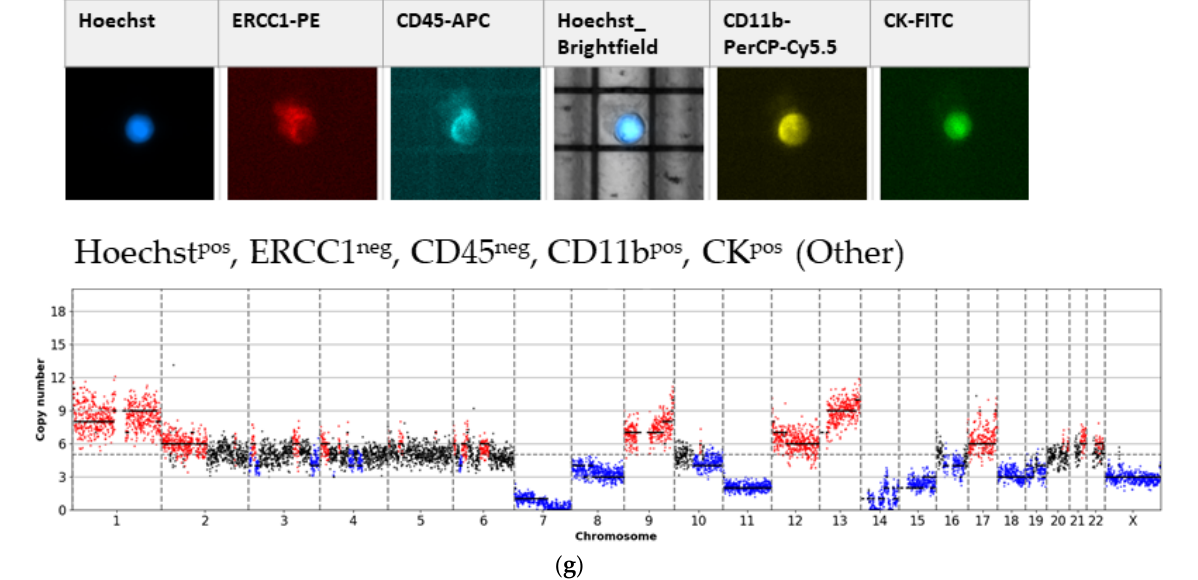
Figure A5. DEPArray TM fluorescence panel of single cells with matched CN profiles showing genome wide CNAs. ( a ) Type A-cell (Hoechst pos , ERCC1 pos , CD45 neg , CD11b pos , CK pos ) with matched CN profile and a ploidy of 2 from patient 8. ( b ) Type A-cell (Hoechst pos , ERCC1 pos , CD45 neg , CD11b pos , CK pos ) with matched CN profile and a ploidy of 2 from patient 8.